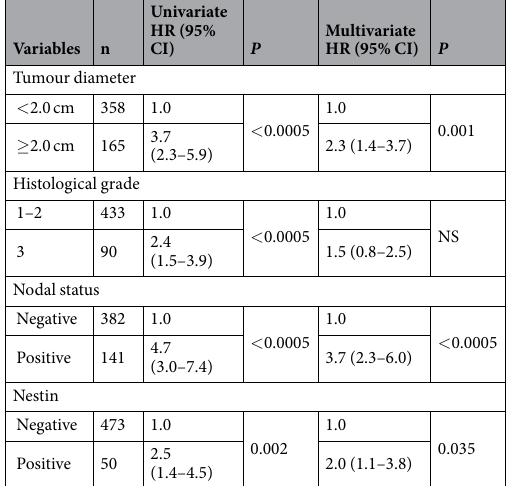
Table 6. Univariate and multivariate survival analysis (Cox’ proportional hazards regression) with death from breast cancer as end-point (Series I). n: number of patients; HR: hazard ratio; CI: confidence interval; P: p-values; NS: not significant. Only patients with information on all variables were included in the analysis (n =